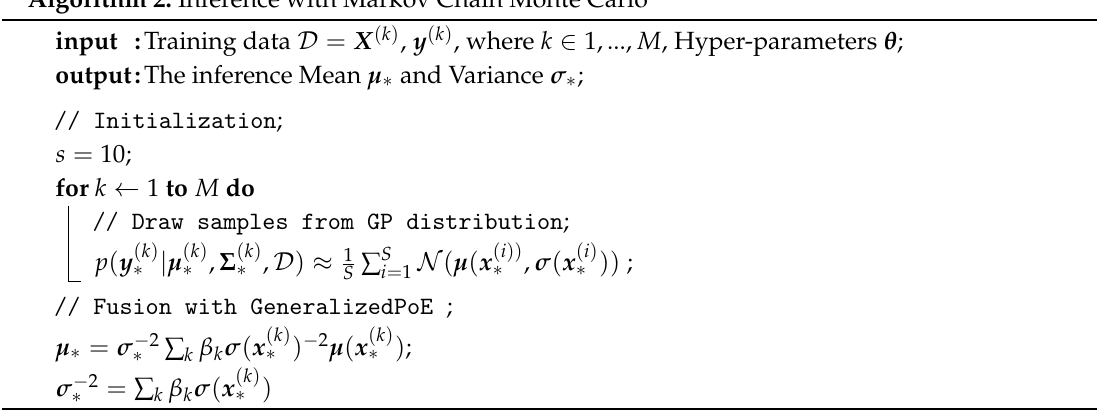
Algorithm 2: Inference with Markov Chain Monte Carlo